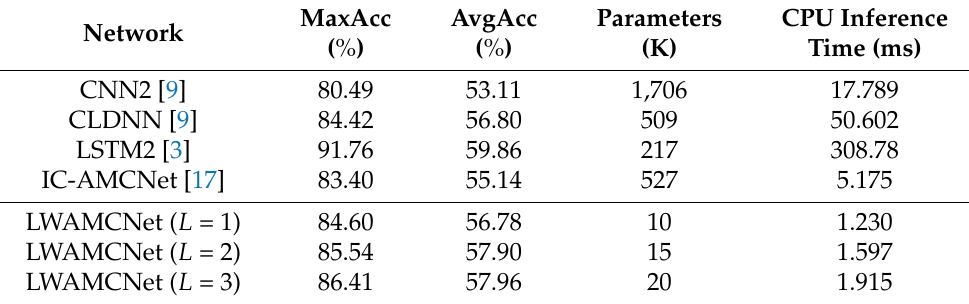
Figure 4. Correct classification probability of different networks on RadioML2016.10A dataset. Table 10. Performance comparison using RadioML2016.10A